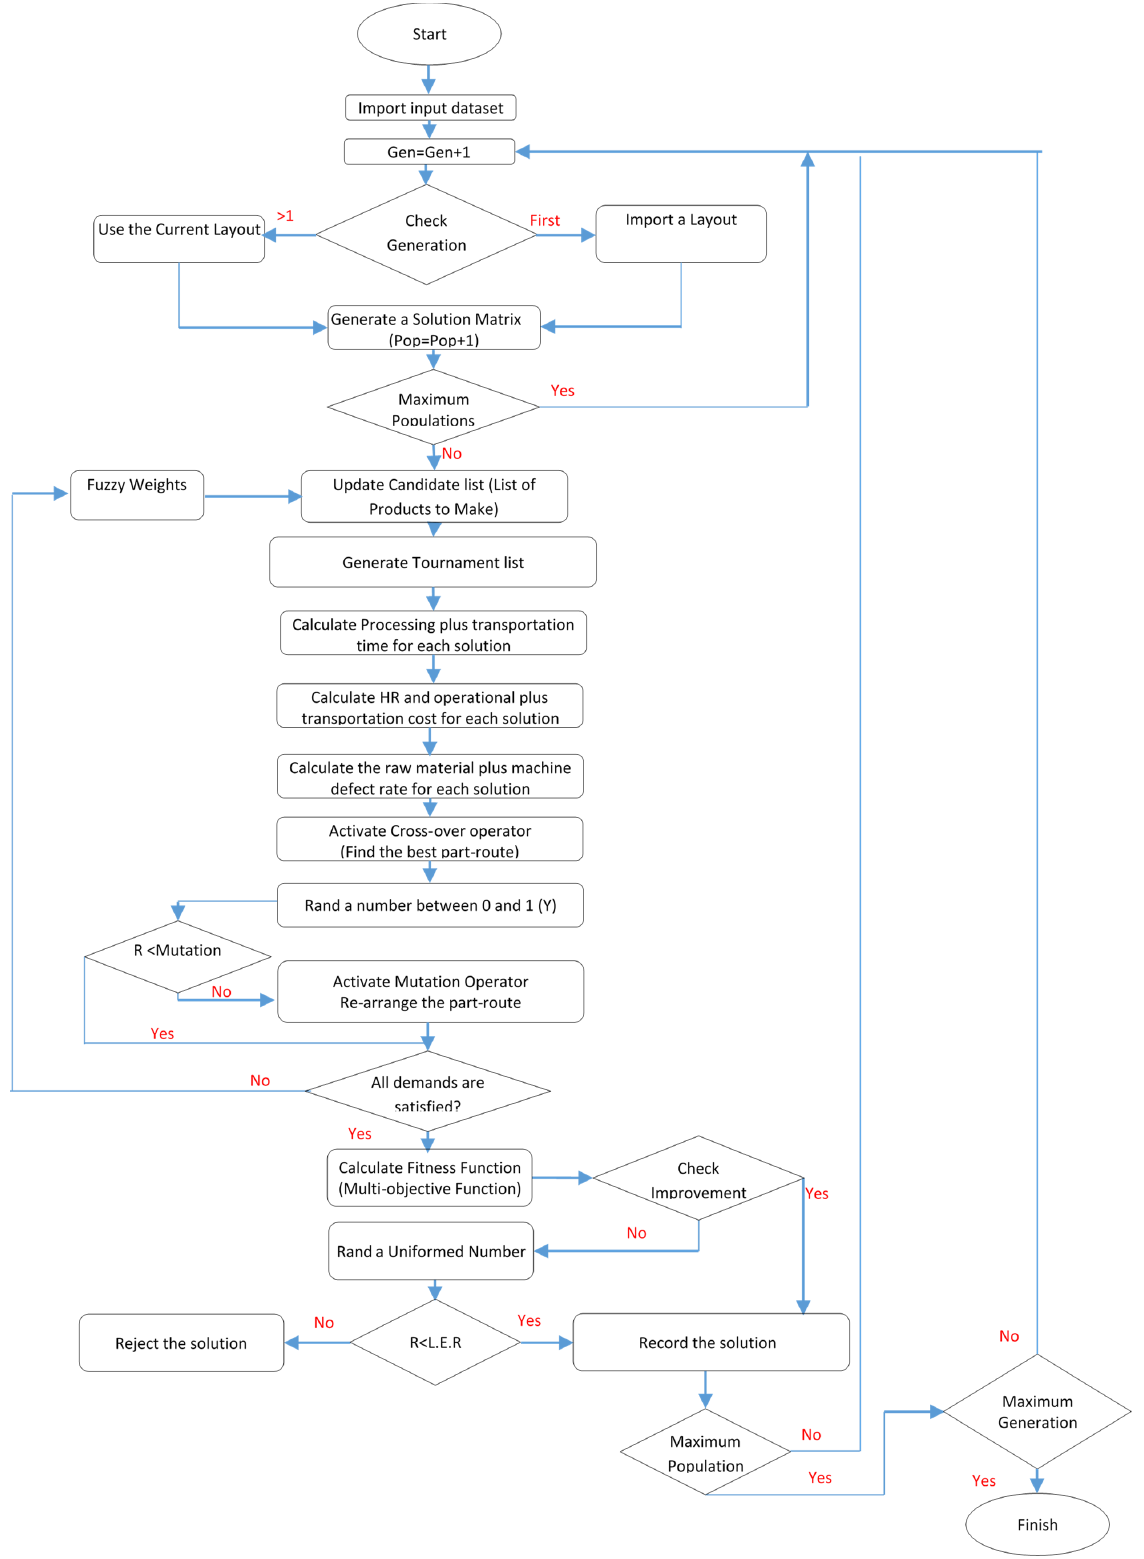
Figure 10. Flowchart of the proposed fuzzy weight NSGA-II.